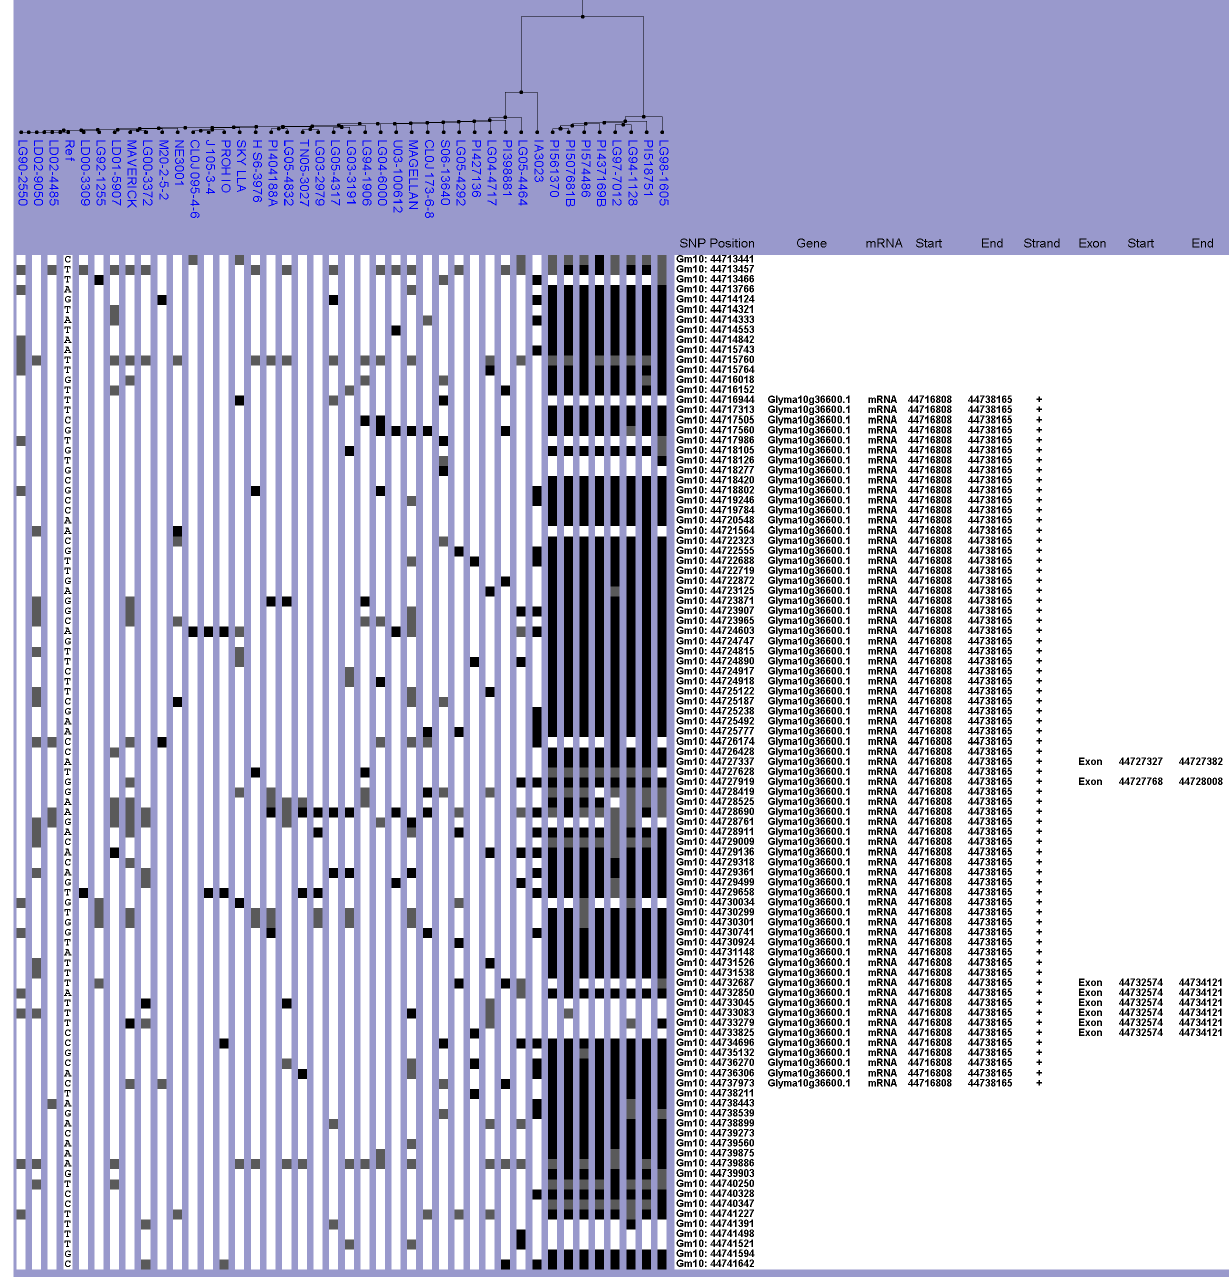
Figure 3. Haplotype analysis of the E2 gene region for the NAM parents. The SNPViz clustering pictorial displayed the SNPs in a 28.3-kb region on chromosome ten, which included Glyma10g36600. Nucleotide polymorphisms were examined in the NAM parents (blue). Details about the SNPViz clustering pictorial were described in the Figure 1 legend.